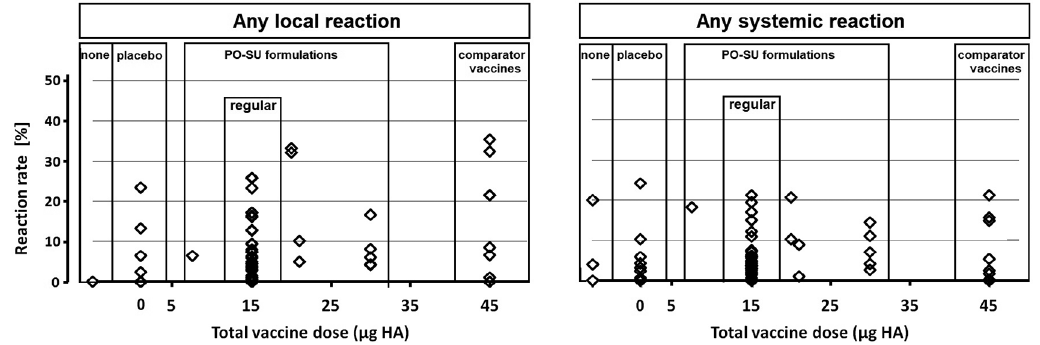
Figure 2. Local and systemic reaction rate estimates from 69 single intervention arms. Legend: Symbols represent local and systemic reaction rate estimates from single intervention arms, arranged according to increas- ing total vaccine